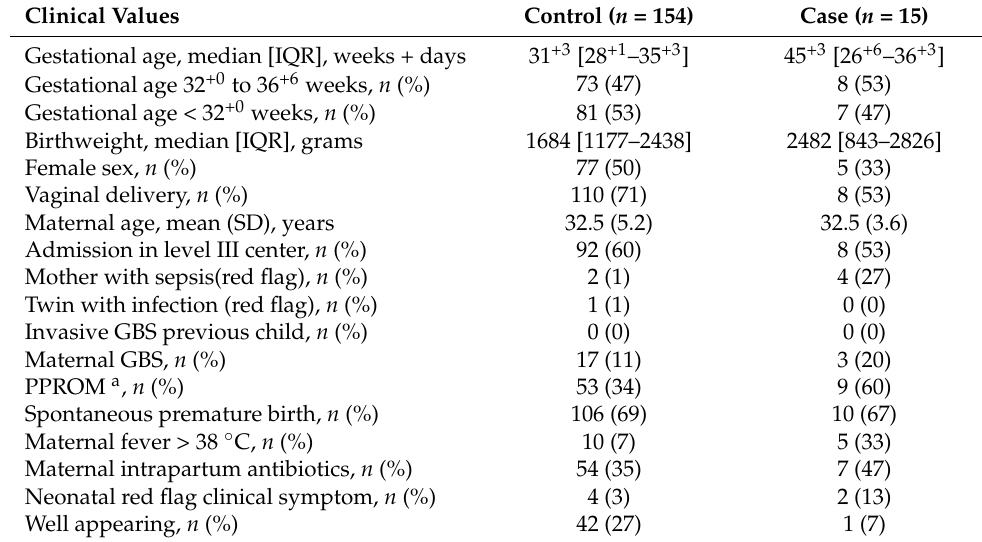
Table 2. Baseline characteristics of preterm-born